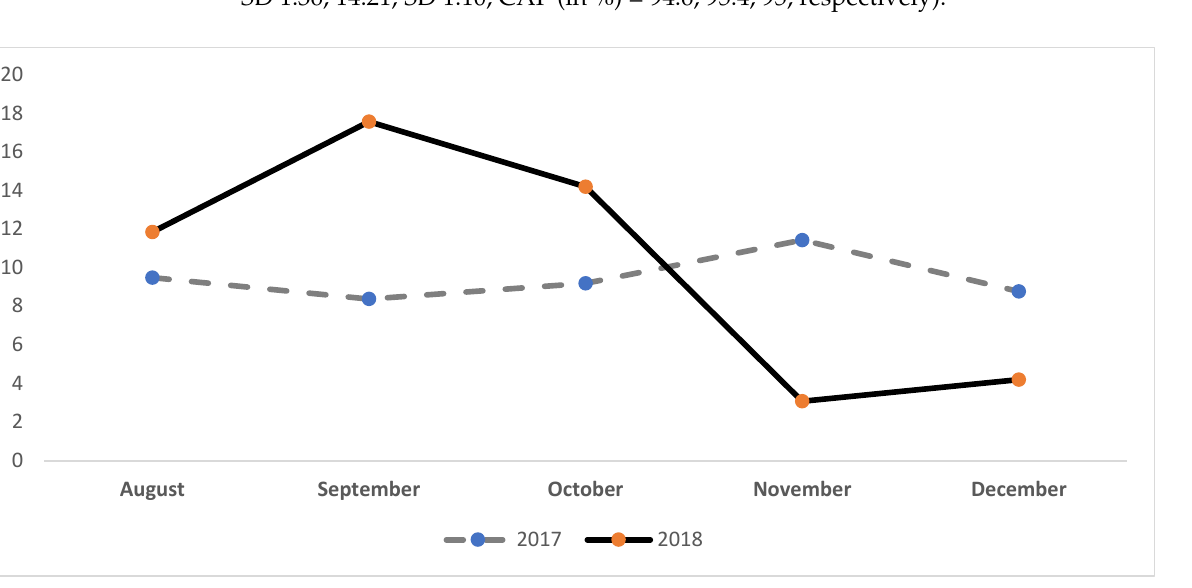
Figure 3. Beaumont Mary Air Monitor Monthly MAX Values, Hydrogen Sulfide 2017-2018. Note: Figure 3 shows air mon- itoring data in parts per billion (PPB) for H2S from August to December in 2017 and 2018.